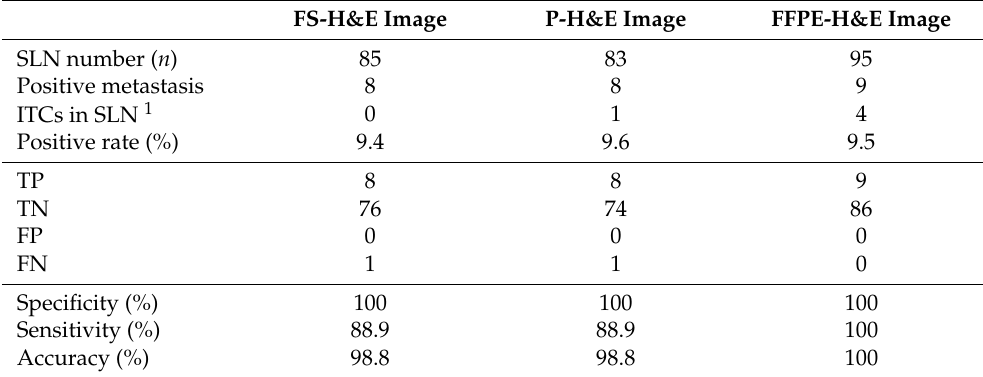
Table 3. Comparison of FS-H&E, p-H&E, and FFPE-H&E assessments of the same